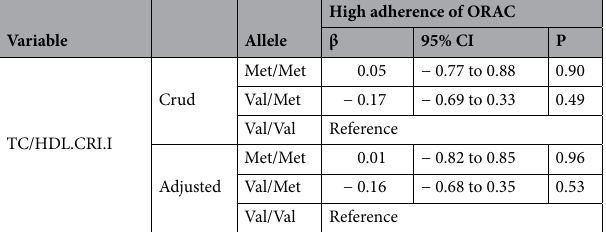
Table 5. The interaction of BDNF Val/Met polymorphism and ORAC on anthropometric indices, lipid profile and atherogenic indices. Val/Val genotype is considered as a reference. Low adherence of DTAC is considered as a reference. Generalized linear model; crude model and adjusted model Age, physical activity, sex, smoking, alcohol, energy intake, lipid, and glucose-lowering medicines, and family history of diabetes, as covariates. Bold values denote statistical signifcance at the P < 0.05 level. ORAC oxygen radical absorbance capacity, CI confidence interval, AIP (Atherogenic index of plasma): log(TG/HDL), AC